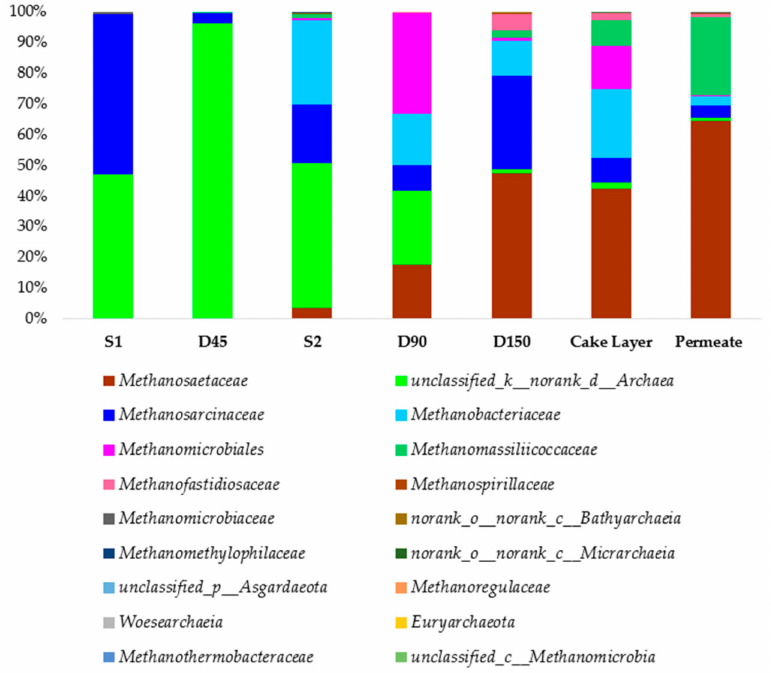
Figure 5. The community bar plot analysis of archaeal at family level sludge, cake layer and cleaning